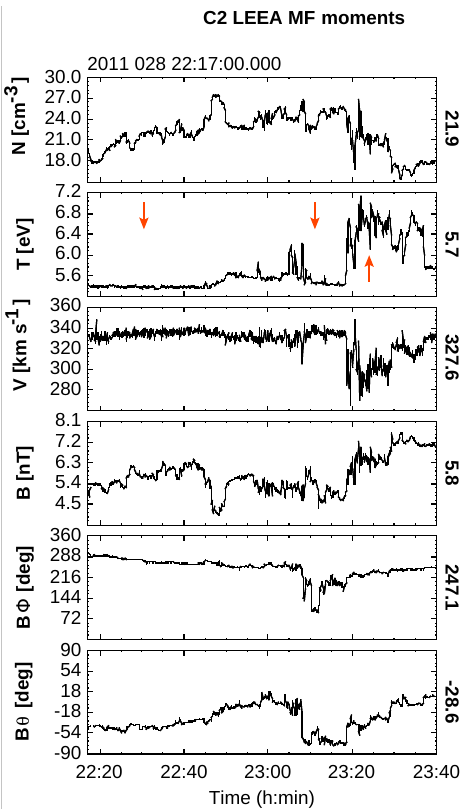
Figure 9. Plots of the total electron density, temperature, and speed and magnetic field components in spherical coordinates across the time interval in Fig. 8. The enhancements in the total temperature between 23:20 and 23:35 indicate times when the spacecraft was in the foreshock. Red arrows in the figure show the locations of the data in the columns shown in Fig.